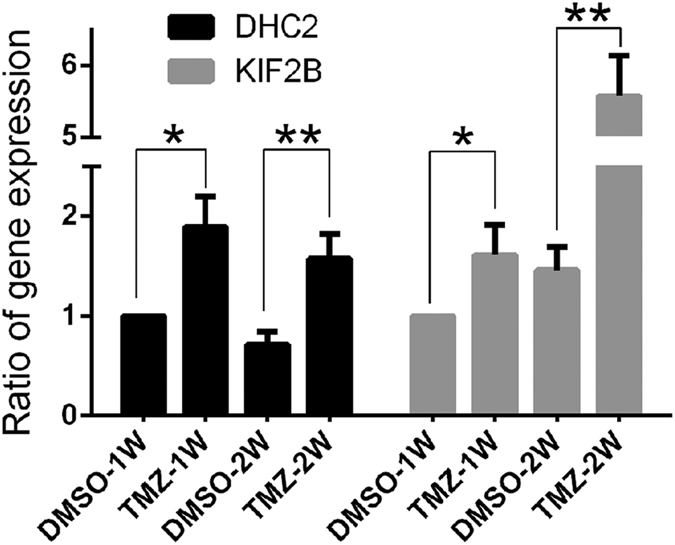
qRT-PCR validation of DHC2 and KIF2B expression in temozolomide-treated cells.Expression of DHC2 and KIF2B mRNA was detected in GBM cells treated with 200 μM temozolomide or DMSO for one to two weeks using qRT-PCR (*P < 0.05 and **P < 0.01).